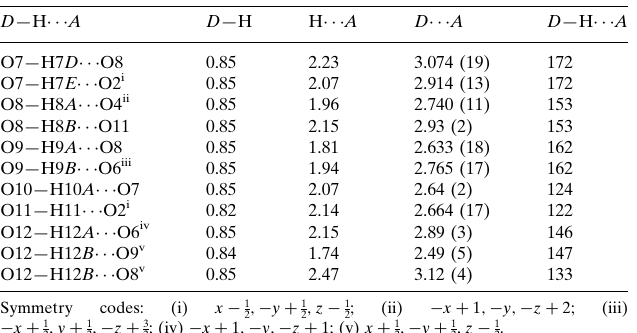
Hydrogen-bond geometry (A˚ , (cid:2)